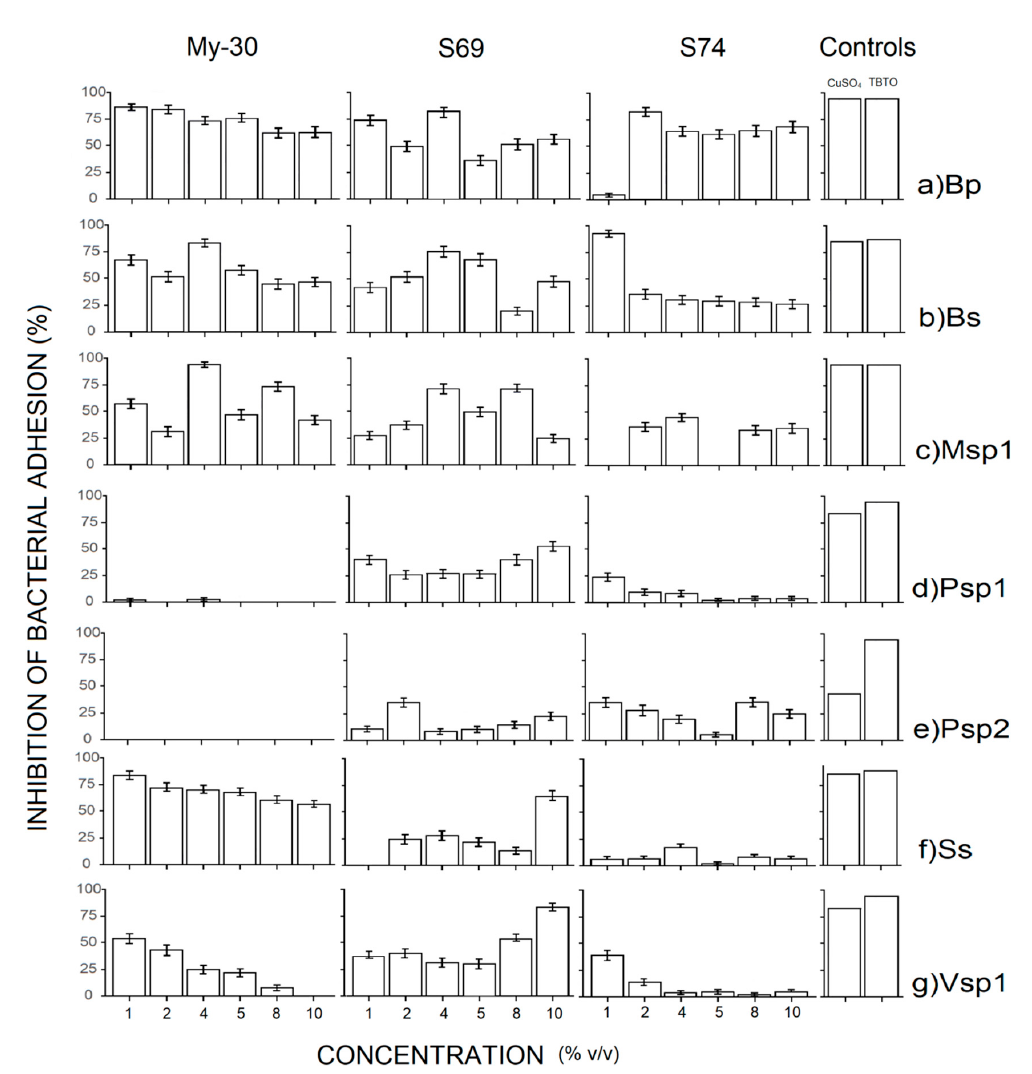
Figure 2. Assessment of the efficiency of bacterial supernatants of Bacillus niabensis (My-30 and S-69) and Ralstonia sp. (S-74) for the inhibition of bacterial adhesion, ( a ) Bp (Bacillus pumilus), ( b ) Bs (Bacillus subtilis), ( c ) Msp1 (Micrococcus sp. 1 ), ( d ) Psp1 (Pseudoalteromonas sp.1 ), ( e ) Psp2 ( Pseudoalteromonas sp.2 ), ( f ) Ss (Sagittula stellata) and ( g ) Vsp1 (Vibrio sp.1 ). C ontrols CuSO 4 (Cu) and TBTO were assayed at 10 µ g mL − 1